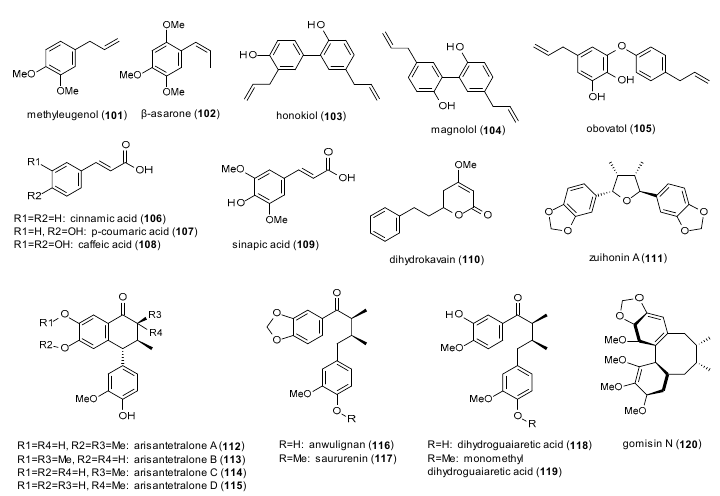
Figure 7. Chemical structures of phenylpropanes, kavalactones and lignans with reported GABA(A)- Figure receptor modulating activity.